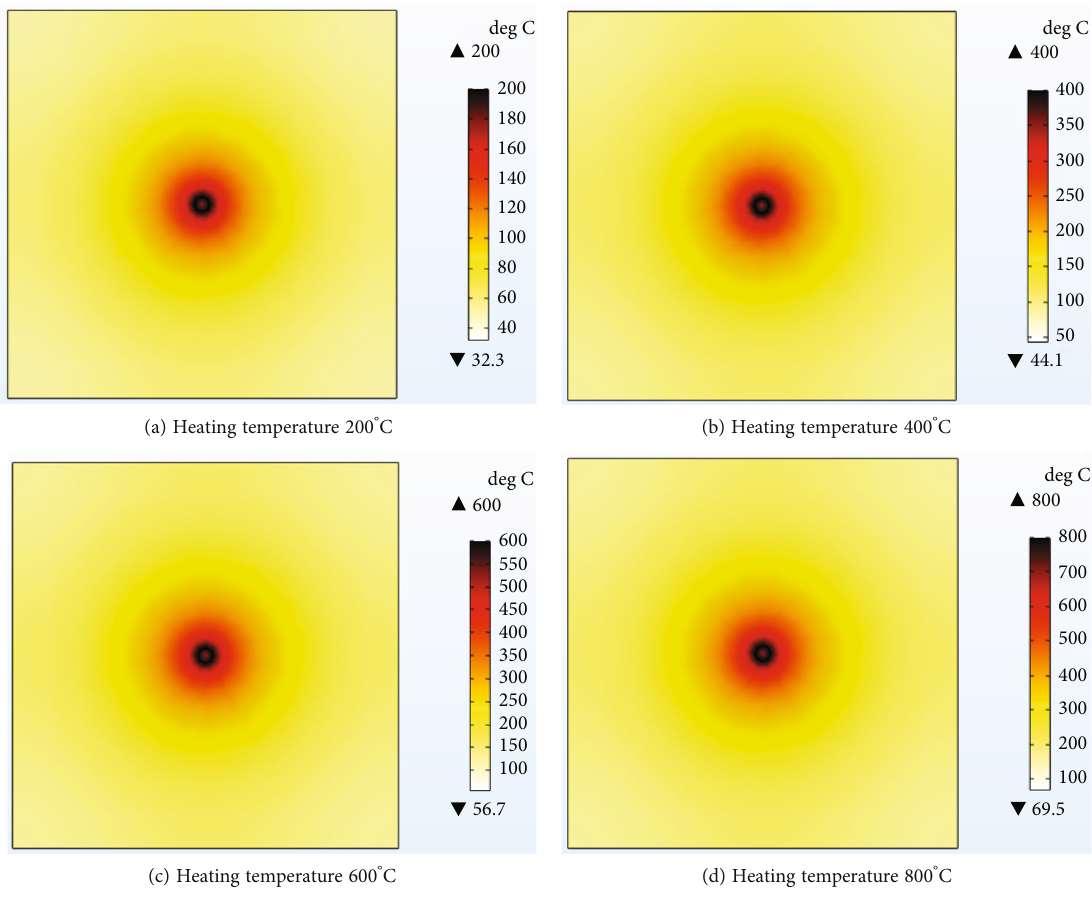
Figure 2: Temperature fi eld distribution under di ff erent heating